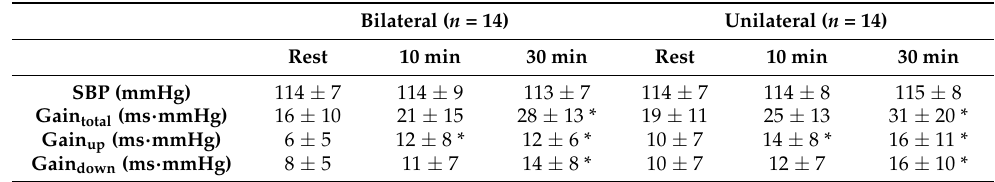
Table 4. Measures of blood pressure and baroreflex sensitivity at rest and during recovery from bilateral and unilateral upper body acute resistance exercise ( n = 14; Men: 7; Women: